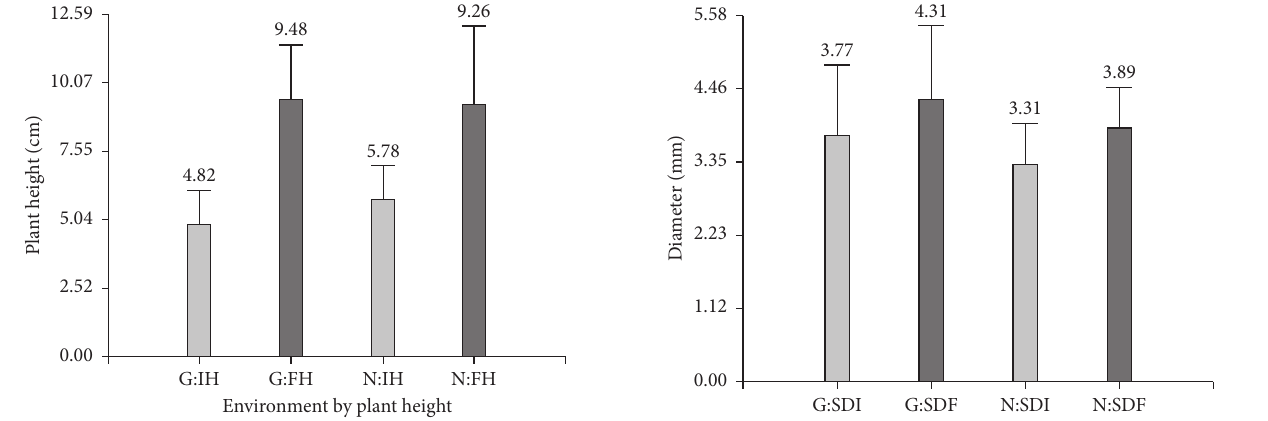
Figure 2: Height (cm) of coffee plants in nursery and greenhouse.